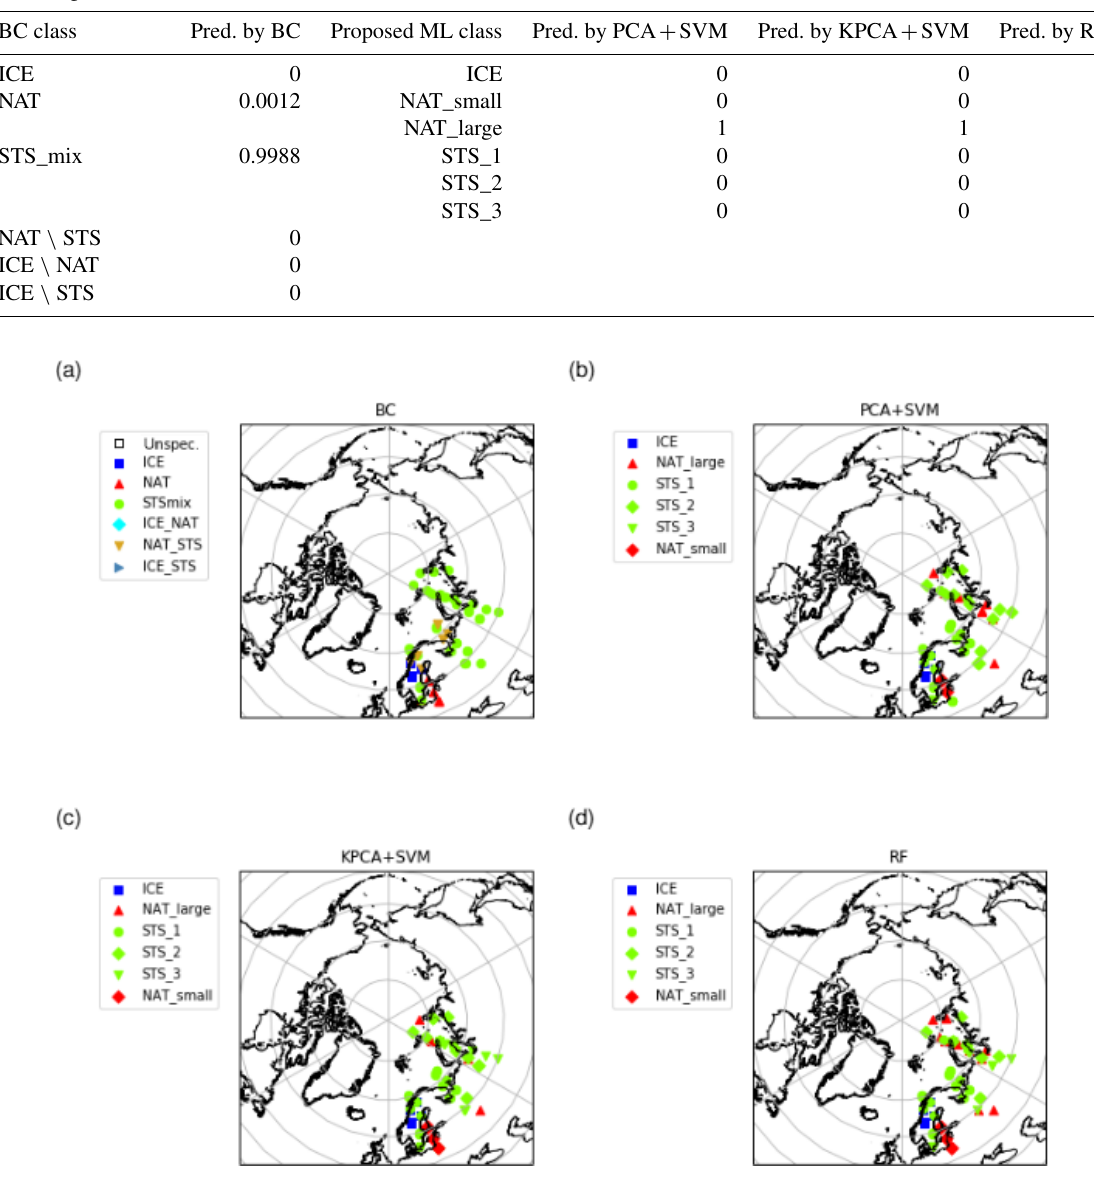
Figure 10. Same as Fig. 8 but for 25 January 2007 and the Northern